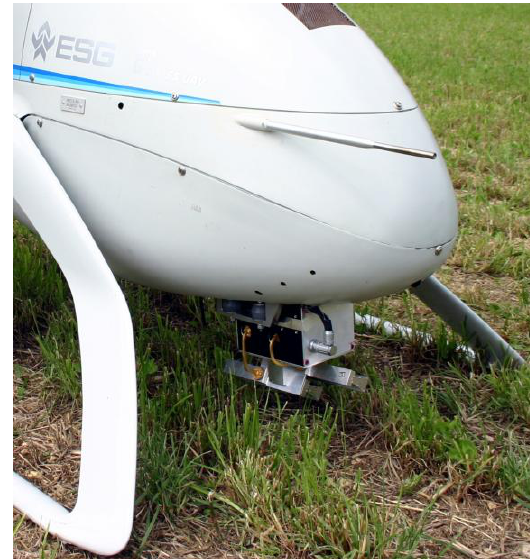
Fig. 11 SAR sensor package mounted on UMAT